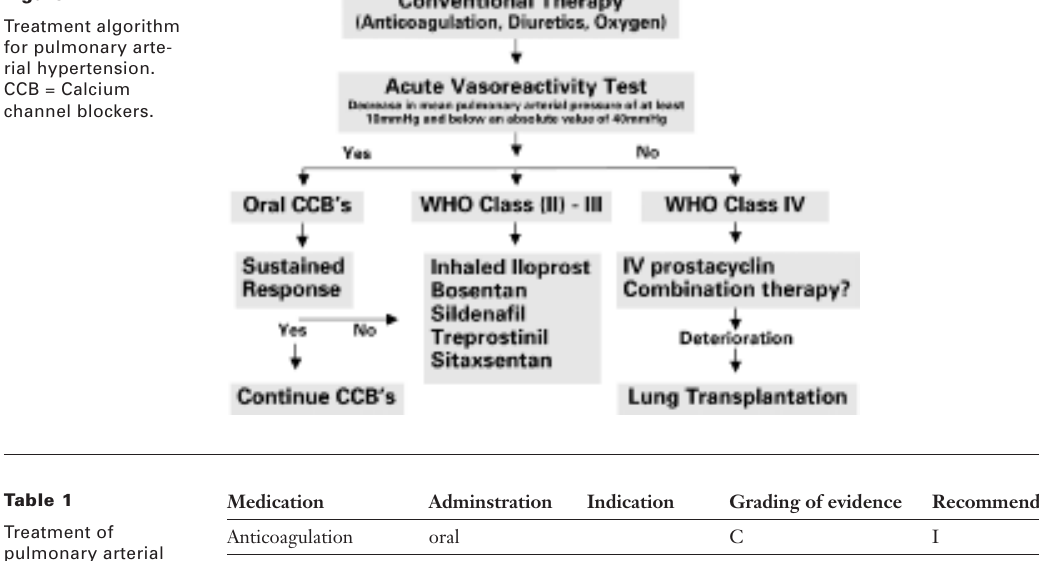
Table 1 Treatment of pulmonary arterial hypertension.